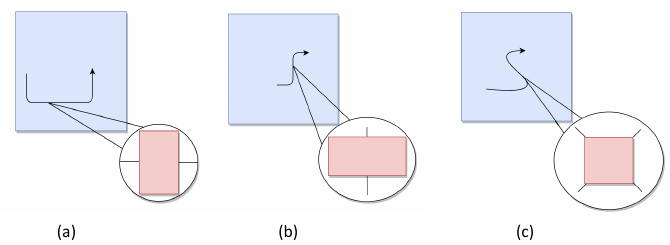
Figure 4. Shapes of ADT filter: ( a ) 0 ◦ filter in horizontal direction ( b ) 90 ◦ filter in vertical direction ( c ) 45 ◦ or − 45 ◦ filter in diagonal directions. The blue squares indicate the input images and the arrows in blue square indicate the boundaries found by canny method. The pink quadrilaterals indicate the shape of filters. Rectangle filter refers to horizontal and vertical direction, square filter refers to sloped direction.